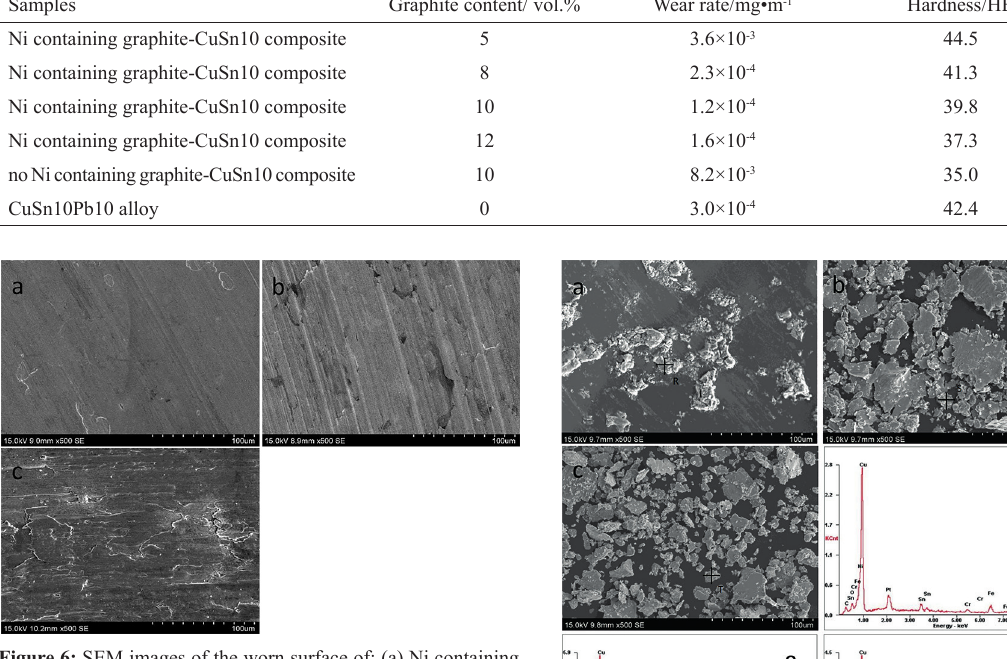
Figure 6: SEM images of the worn surface of: (a) Ni containing graphite-CuSn10 composite layers with 10 vol% graphite, (b) no Ni containing graphite-CuSn10 composite layers with 10 vol% graphite, (c) CuSn10Pb10 alloy layers.